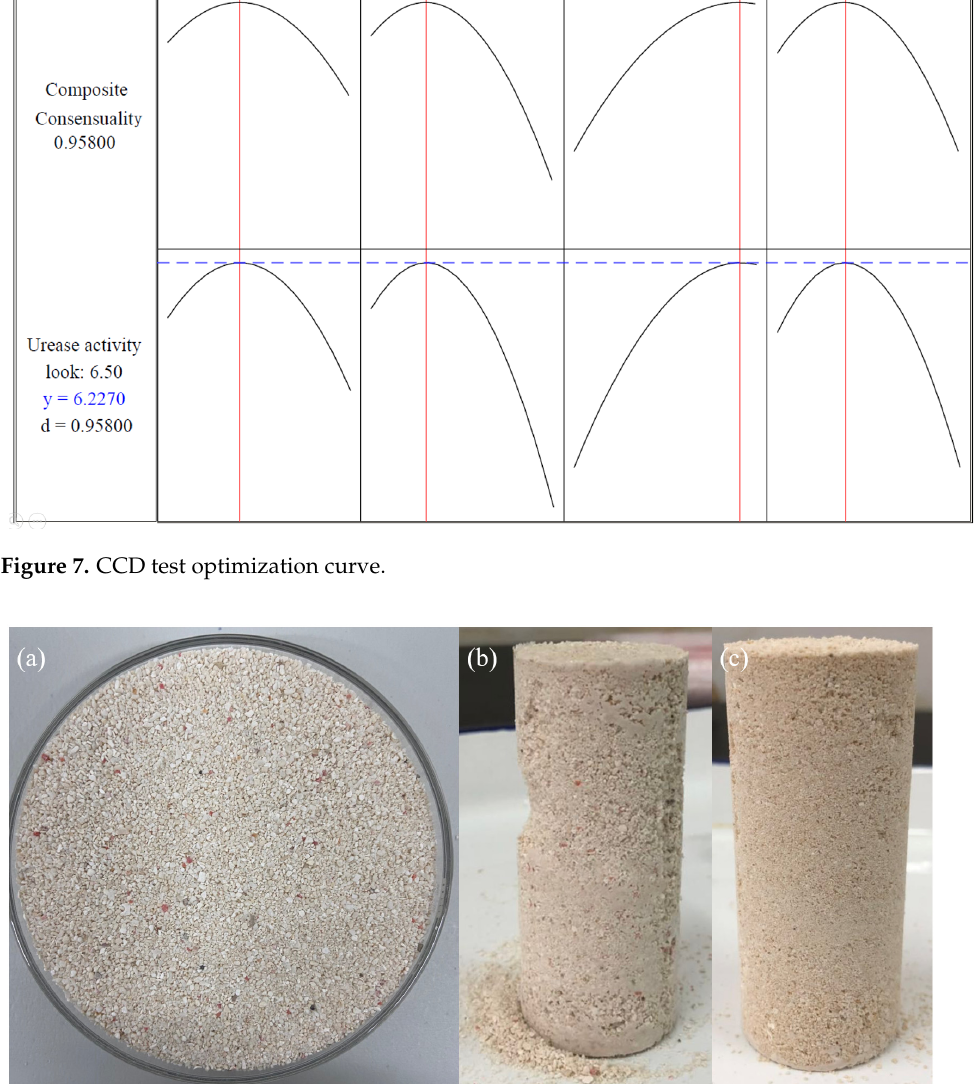
Figure 9. Calcium carbonate contents of samples. 3.4. UCS Test and Analysis The UCS results of the calcareous sand columns in each group are shown in Figure 10. Group C1 fractured during demoulding due to a short mineralization time, so the UCS was 0. The content of calcium carbonate was lowest in Group C2. However, the strengths of the samples treated with the optimal stimulation scheme were improved, and the un- confined compressive strengths reached 80 kPa. This increase also occurred in the 10- round test scheme of mineralization, and the UCS of Group C4 reached 770 kPa, which was 83.33% higher than that of Group C2. These results also showed that for a given stim- ulation solution, increasing the number of mineralization cycles significantly improved the mechanical strength of the sand column. The test shows that increasing the number of mineralization cycles and using the stimulation program with high urease activity can effectively improve the reinforcement effect. C1:ISS+CS C2:ISS+CS C3:OSS+CS C4:OSS+CS02 4 6